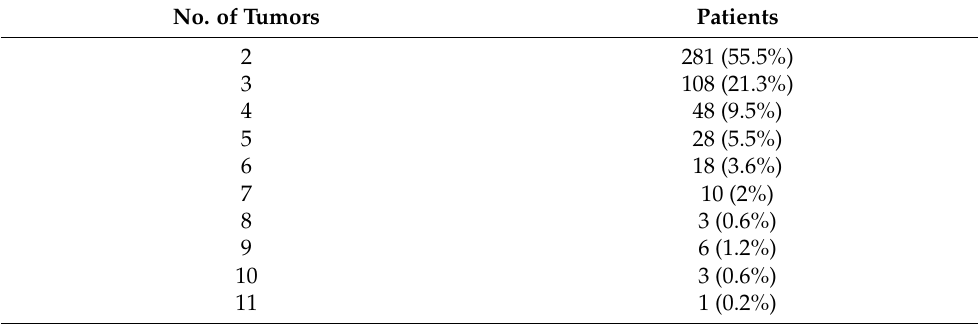
Table 2. Patients affected by multiple